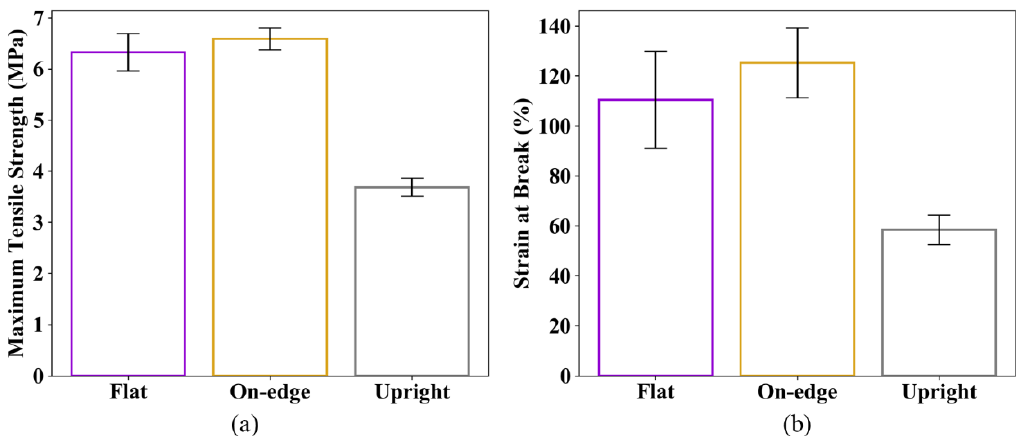
Figure 9. Average and standard deviation of the results: ( a ) Maximum tensile strength and ( b ) strain at break.